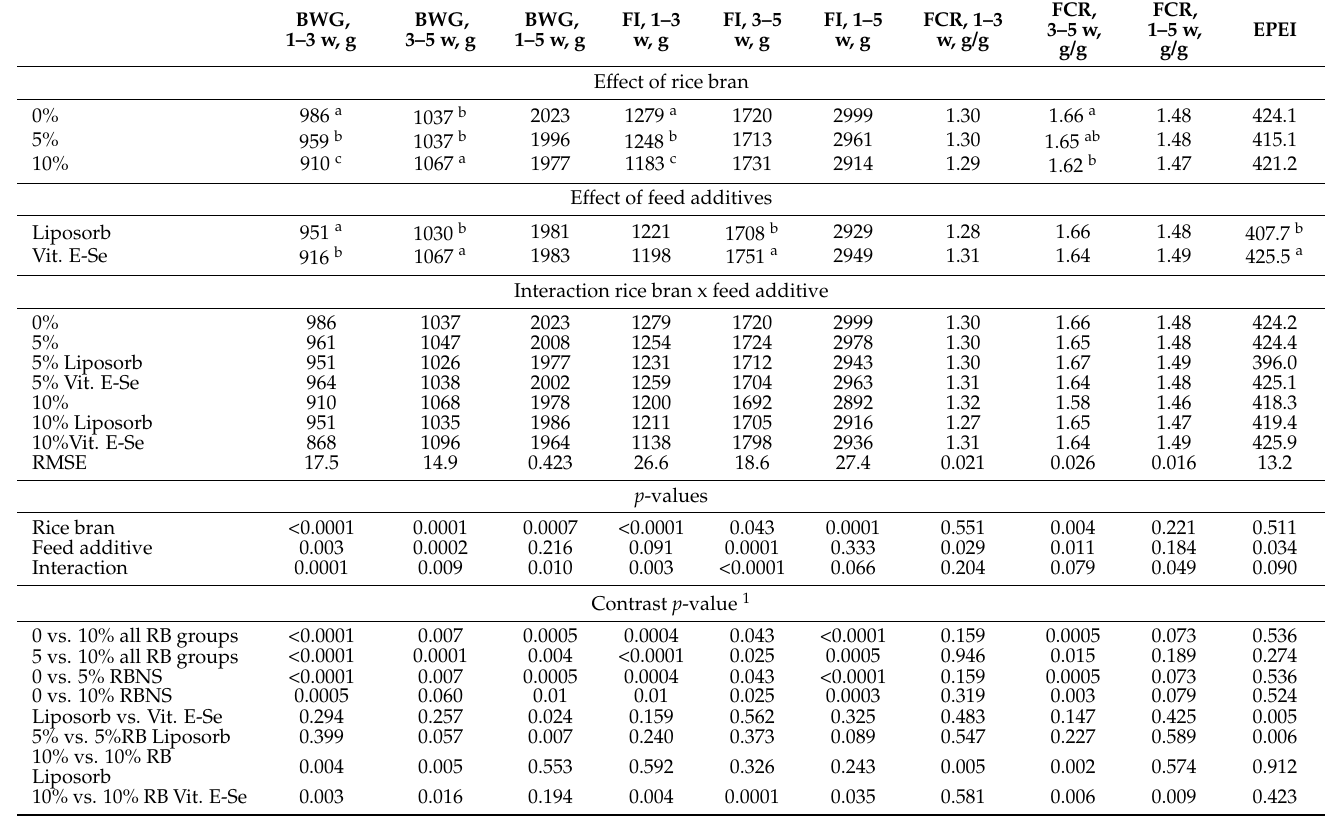
Table 3. Growth performance of broiler chickens as affected by dietary rice bran treatments during the